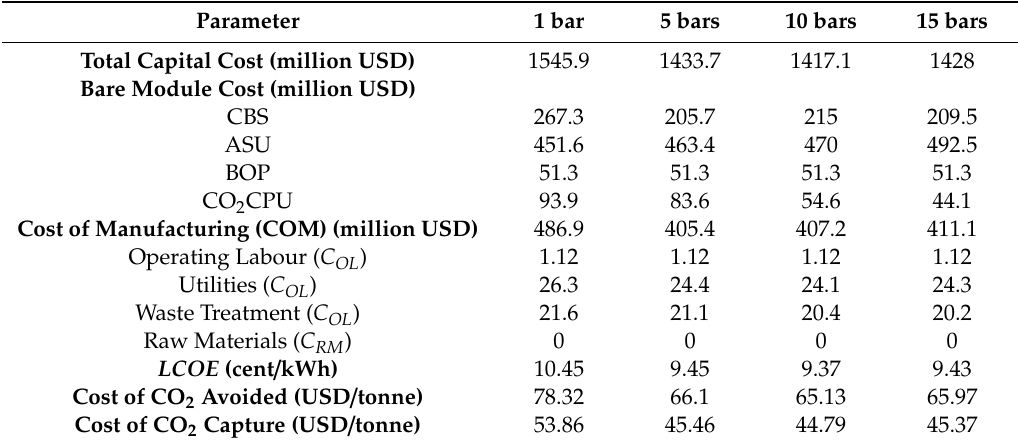
Table 5. Economic model results for oxy-petcoke plant at di ff erent pressures in the USA.